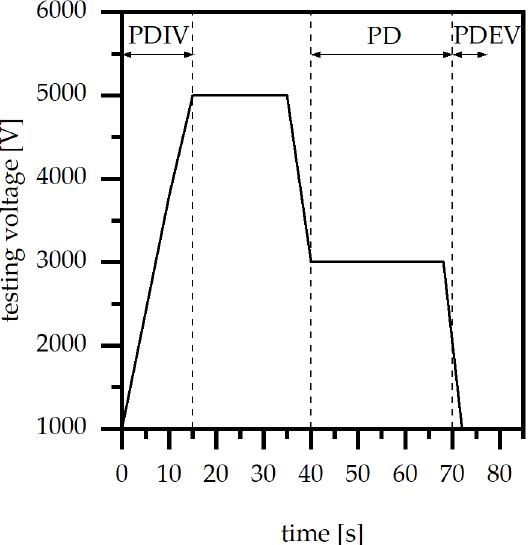
Figure 2. Testing voltage for the measurement of the average of partial discharge (PD), the partial discharge inception (PDIV) and the extinction voltage (PDEV).